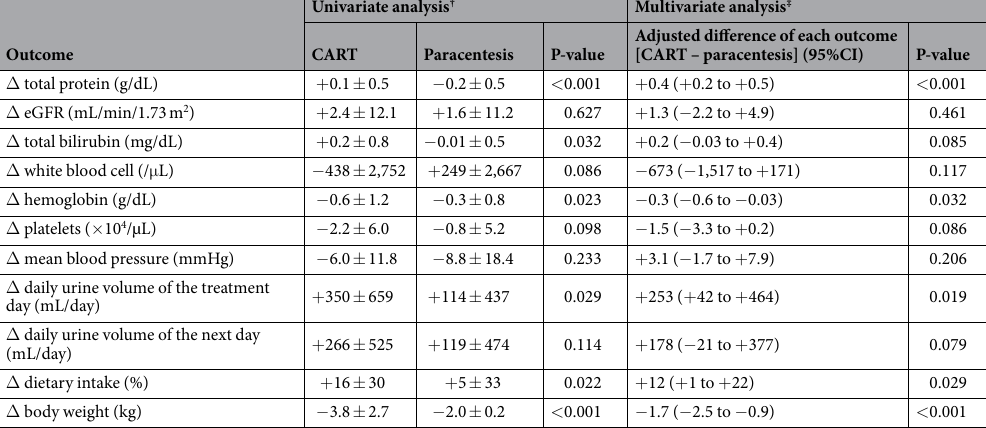
Table 4. Differences in secondary outcomes between CART and paracentesis. Δ indicates change from pre- treatment to post-treatment. † Indication method, mean ± SD; P-values were calculated by the Student t -test. ‡ Multiple linear regression analysis was used. Difference of each outcome was adjusted for ALBP, FFP, RCC, and infectious diseases.